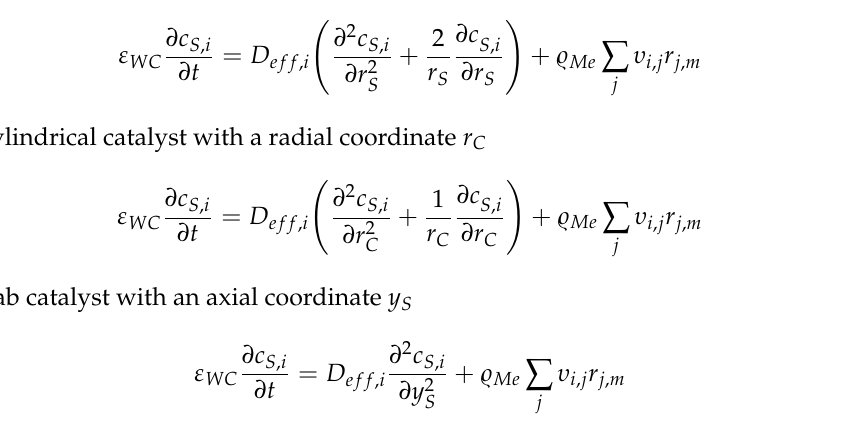
Table 1. Kinetic parameters of the rate expressions to describe the 41 experimental concentration- time plots for single sugar hydrogenation [43] as well as sugar mixture hydrogenation [67].